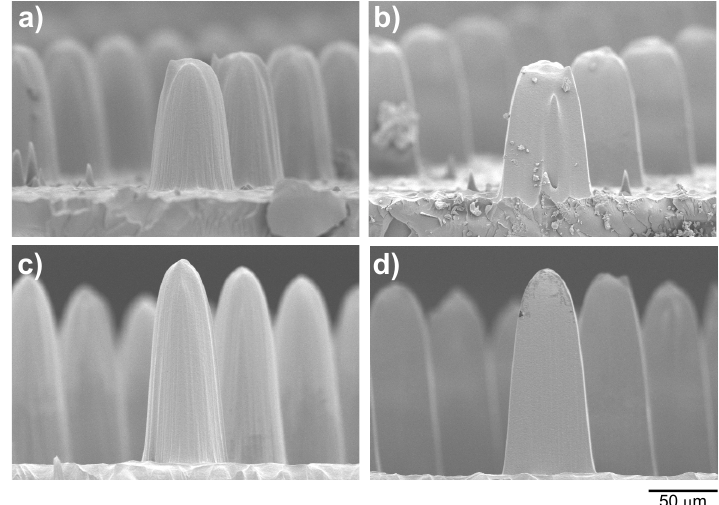
Figure 7. Cross-sectional SEM images of the PMMA structures, which ( a , c ) cone and ( b , d ) pyramid shapes of Si absorber were transferred by the X-rays at dose energies of 50 and 300 mA, respectively.